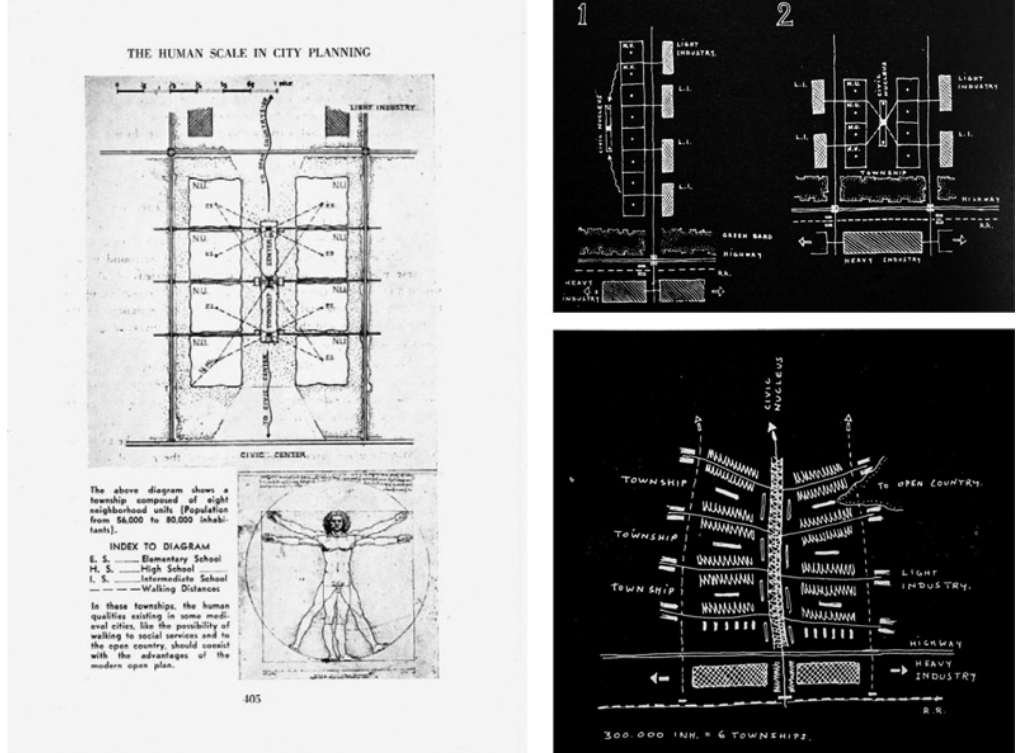
Figure 1. Sert’s “The Human Scale in City Planning,” 1944. Source: Sert (1944, pp. 402–403,